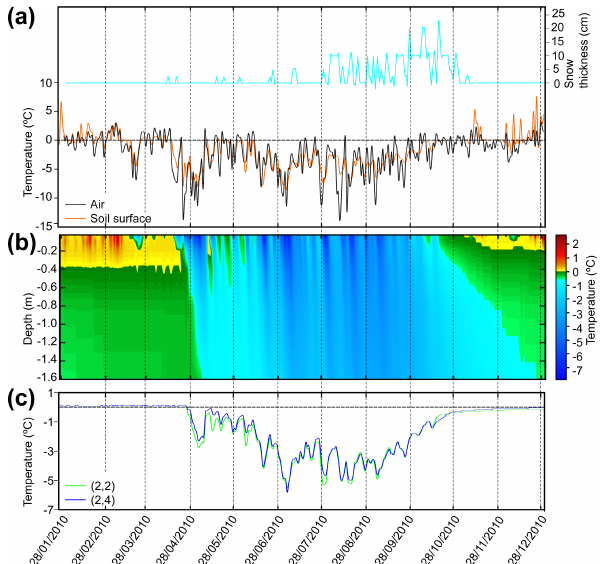
Figure 4. (a) Snow thickness and air and soil surface temperature variability during the A-ERT data acquisition in 2010. (b) Borehole temperature plotted for the sensors installed at the node 3,3 ( S 3 , 3 ), covering the investigation depth of the ERT transect. (c) Shallow borehole temperatures plotted for the sensors installed at nodes 2,2 and 4,2 at the base of the active layer. The dashed lines mark the selected dates for the ERT inversion analysis shown in Fig. 7.